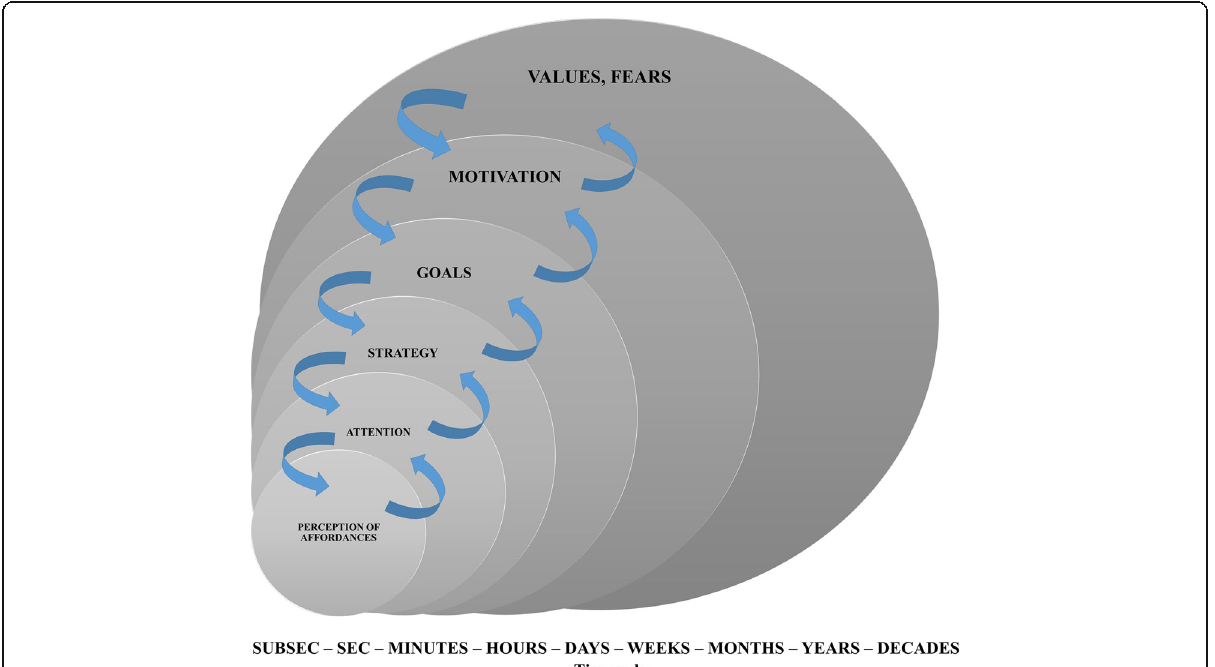
Fig. 4 Example of nested constraints operating at different timescales and correlated through circular causality. The exact timescales given in the figure are only orientative (e.g., goals or motivation can be defined at different